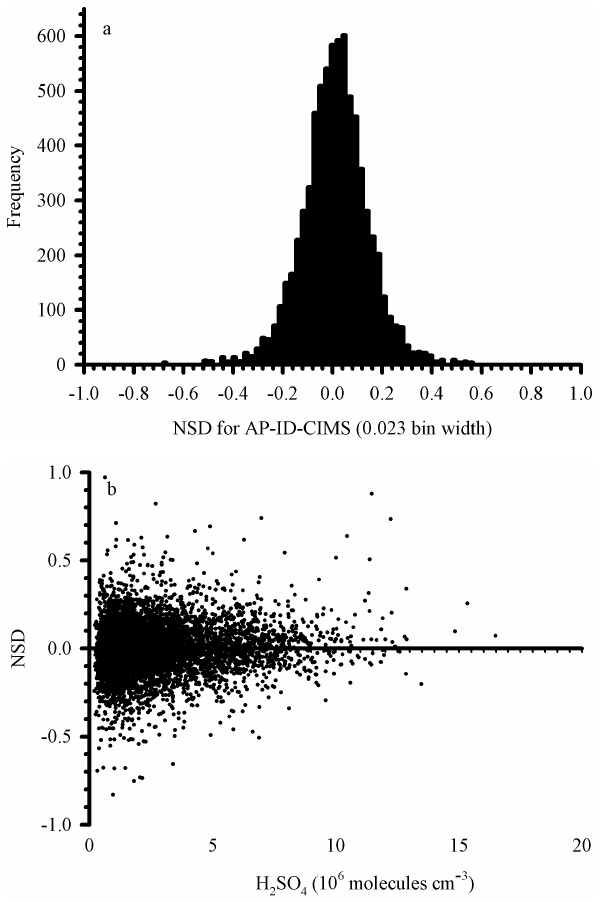
Fig. 1. (a) Frequency histogram of normalized sequential difference (NSD) for the AP-ID-CIMS; (b) scatter plot of NSD with GSA con-